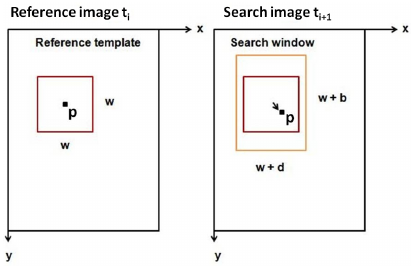
Figure 1: Scheme of the image pairs together with the reference template, the central pixel and the search window.